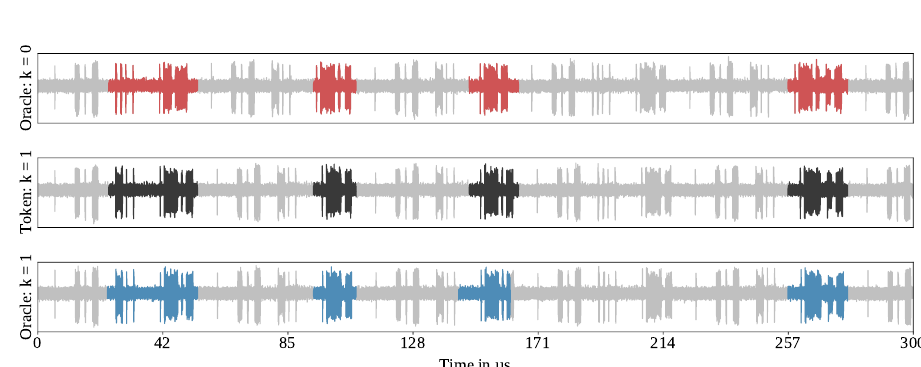
Figure 5: EM traces of the first ladder step of the attacked token (middle) and the oracle with k set to 0 (top) and 1 (bottom). Regions where distinctive patterns from the oracle trace match with the token are highlighted in blue and red